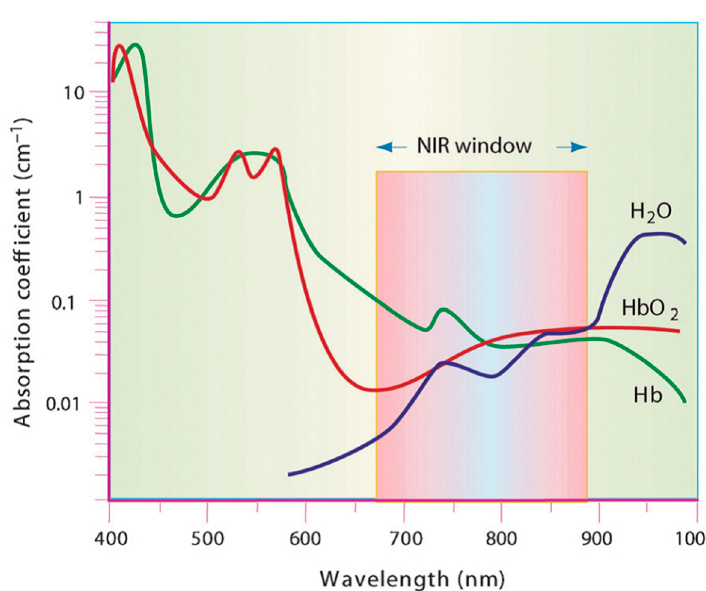
Figure 2. Absorption coefficients of hemoglobin (Hb), oxyhemoglobin (HbO 2 ), and water. The absorption in the range of near-infrared (NIR) window is minimal. Reprinted with permission from Nat Biotechnol 19 (4), 316–317. Copyright 2001 [11].